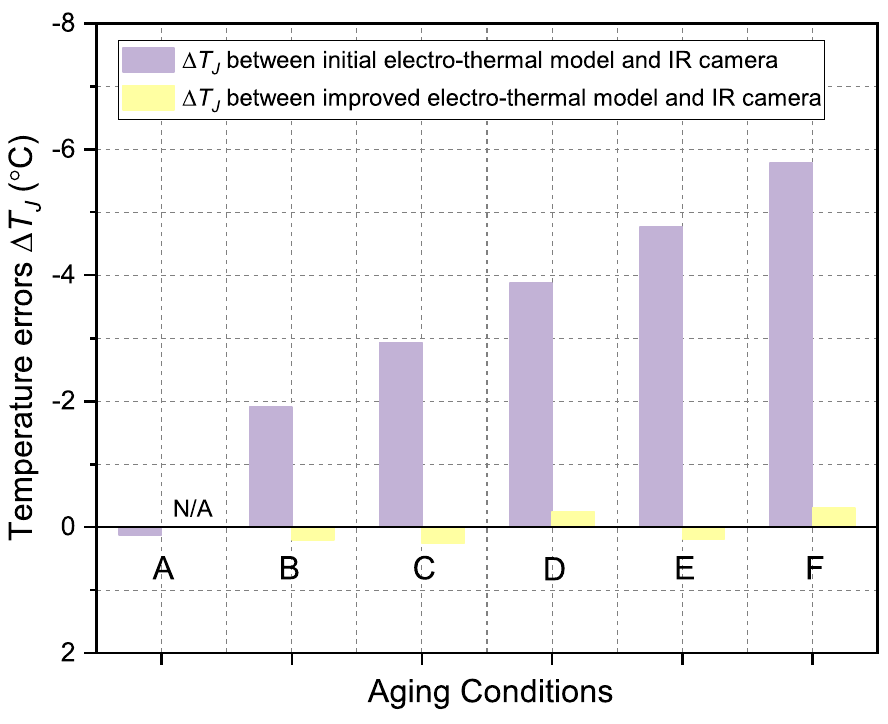
Figure 12. Comparisons of temperature